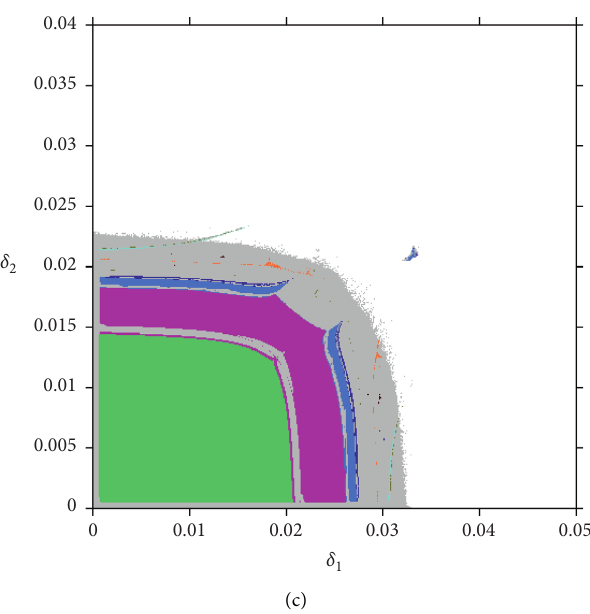
Figure 5: The 2D bifurcation diagrams in the ( δ